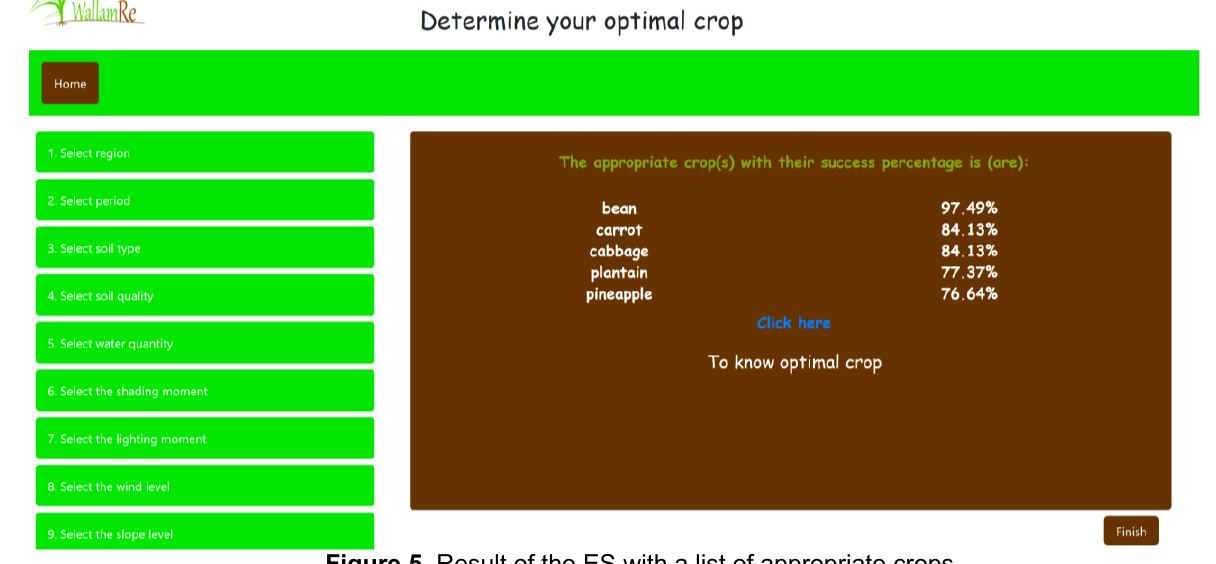
Figure 5. Result of the ES with a list of appropriate crops